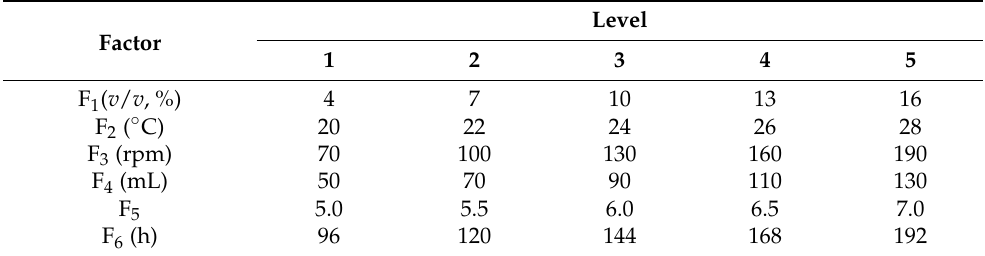
Table 3. The factors and levels of the orthogonal design for culture condition optimization.